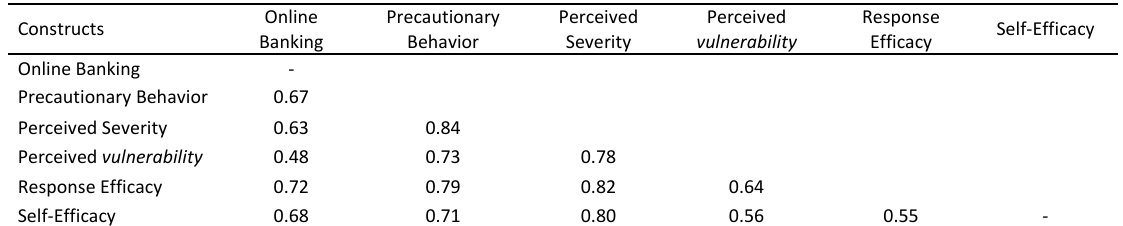
Table 2: Heterotrait-Monotrait Ratio (HTMT)